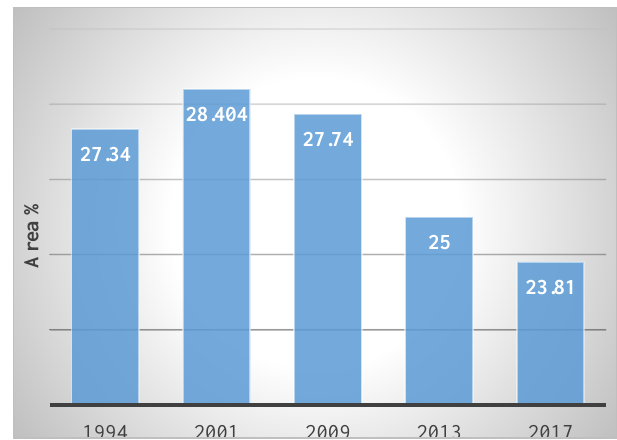
Figure 4: Glacier Area in